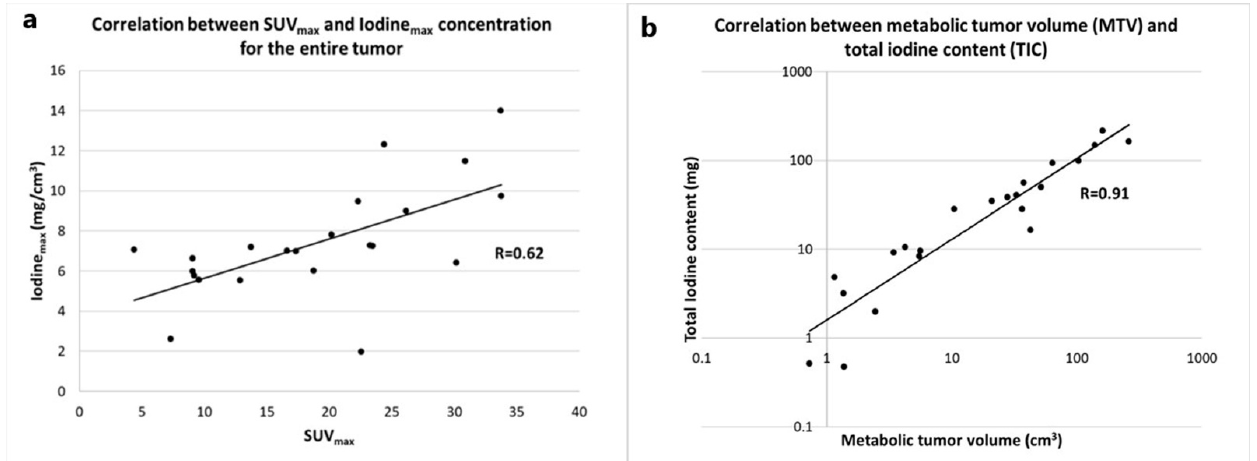
Figure 2. ( a ) Scatter plot showing the correlation between SUV max in the tumor and maximum iodine concentration in the tumor. Data were fitted with a linear function, showing a significant correlation ( p = 0.002). ( b ) Scatter plot showing the correlation between metabolic tumor volume (volume within the tumor with an SUV > 2.5) and total iodine content. Both axes are depicted on a log scale, because values were not normally distributed. Data were fitted with a power function, resulting in a signif- icant correlation with p -value < 0.0001.